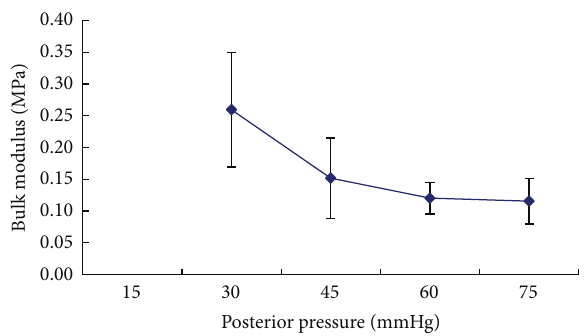
Figure 3: The change of bulk modulus of rabbit corneas with the increase of posterior pressure. The cornea at posterior pressure of 15mmHg was defined as primary condition ( 𝑃 0 ). The bulk modulus was calculated as Δ𝑃/Δ𝑉 , where Δ𝑃 = (𝑃 − 𝑃 0 ) , Δ𝑉 = ( CV 15 )/ CV CV 15 mmHg . posterior pressure